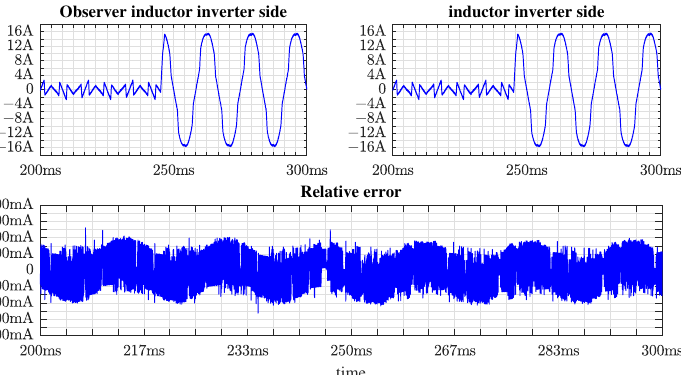
Figure 10. Current waveforms: Observer inductor inverter side, inductor inverter side, and relative observer error.